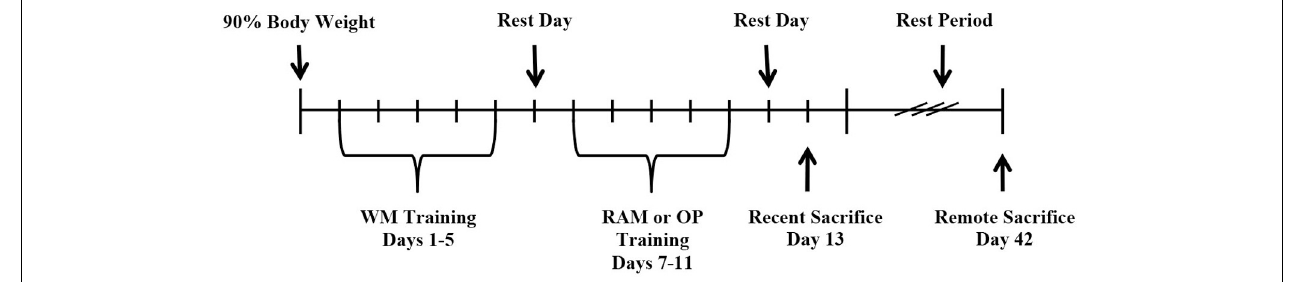
FIGURE 1 | Timeline of experimental procedures.